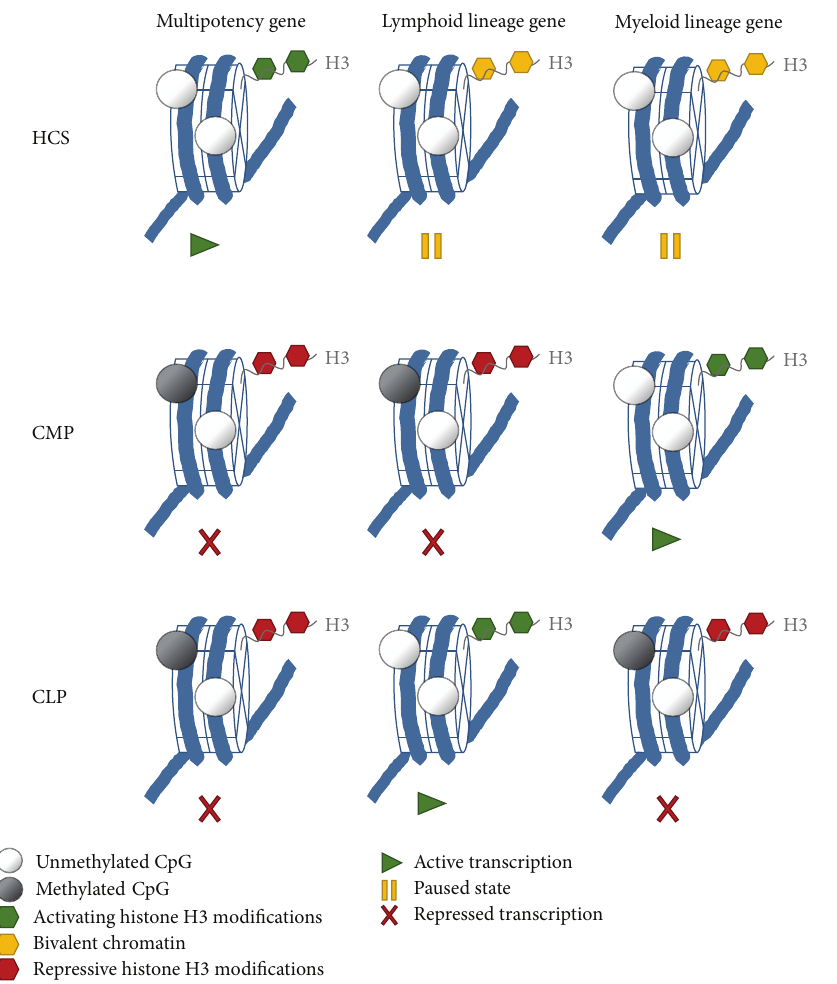
Figure 2: Changes in epigenetic signatures upon HSC differentiation and lineage commitment. Multipotency genes are actively transcribed in hematopoietic stem cells (HSC) to maintain stemness and self-renewal. Promoter and enhancer regions are labelled with activating H3K4 methylation marks (green hexagons) and unmethylated CpG islands (white circles). Key genes, important for lineage commitment and differentiation into progenitor cells of the myeloid (common myeloid progenitors (CMP)) or lymphoid lineage (common lymphoid progenitors (CLP)), are kept in a paused state mainly by the counteracting histone methylation marks H3K27me3 (repressive) and H3K4me3 (activating) in gene regulatory regions, termed as bivalent signatures (yellow hexagons). Upon lineage commitment, multipotency genes are silenced by repressive histone methylation marks (e.g., H3K27m3, H3K9me3, and red hexagons) and partially by gene-specific de novo methylation of CpG islands (grey circles). Upon differentiation bivalent chromatin signatures are resolved depending on lineage choice: paused genes become either activated transcriptionally by accumulation of activating H3K4me3 marks and loss of repressive H3K27me3 or silenced by loss of H3K4me3 and accumulation of H3K27me3 and partially by gene-specific methylation of CpG